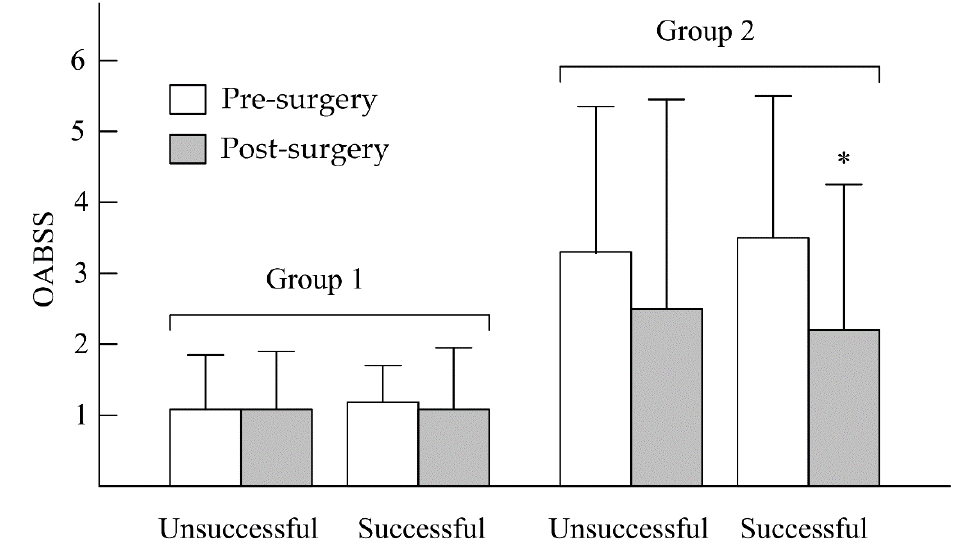
Figure 2. Changes in OABSS between pre- and post-UPPP in non-nocturia (group 1) and nocturia (group 2) patients. * p < 0.05, pre- vs. post-UPPP.